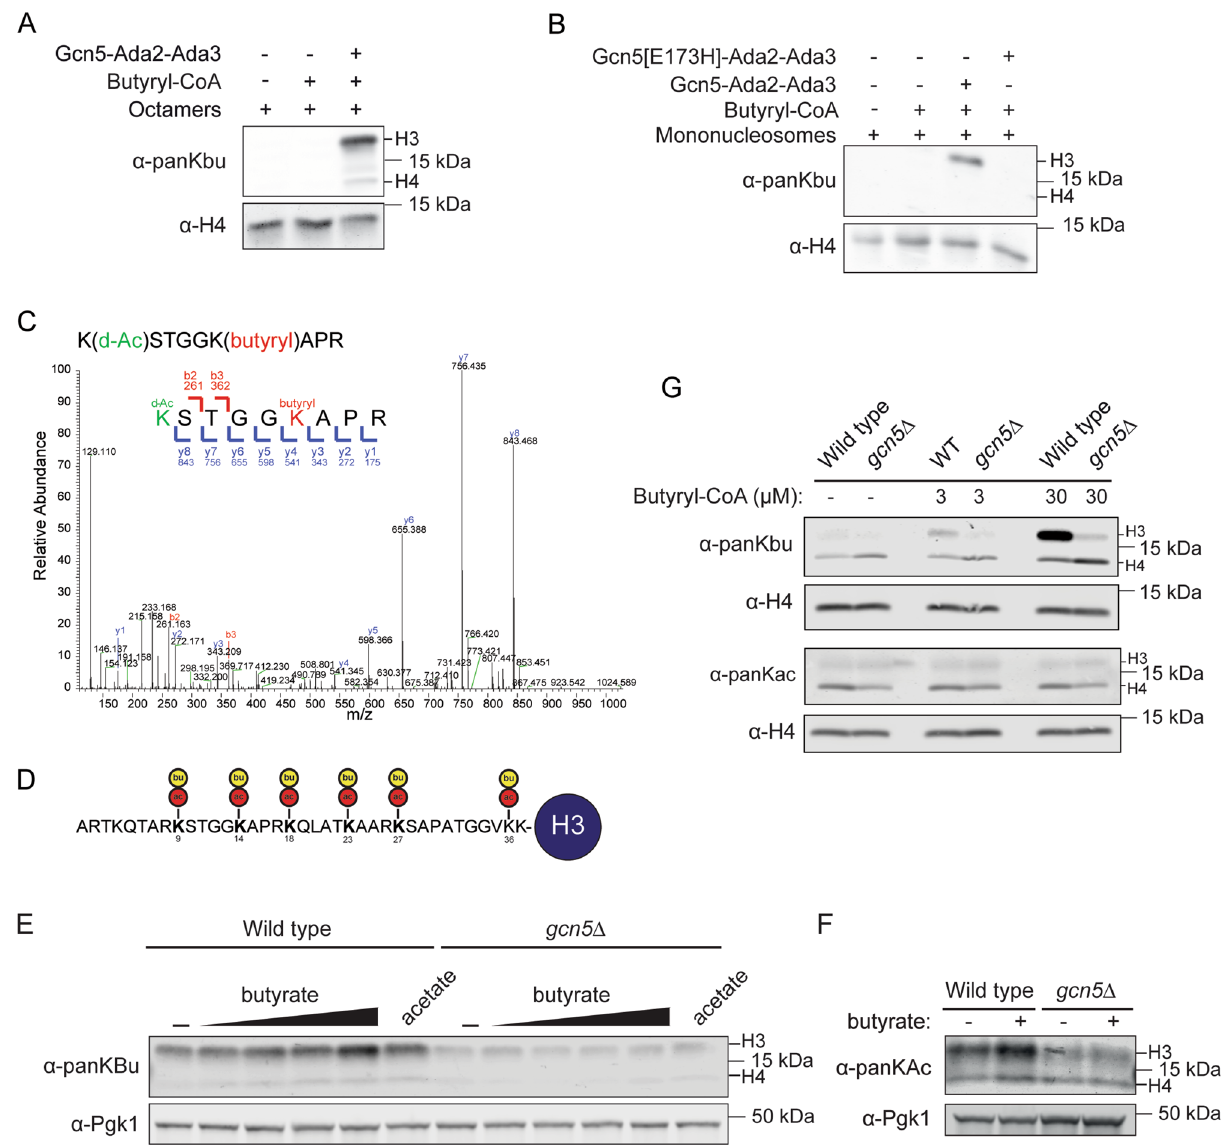
(green). ( D ) Schematic depicting residues 1–37 of H3 with acetylated (ac, red) and butyrylated (bu, yellow) lysine residues as identified by mass spectrometry. ( E , F ) Wild-type and gcn5Δ strains were treated with increasing concentrations of sodium butyrate (1, 2, 5, and 10 mM; pH 7.5) or sodium acetate (10 mM; pH 7.5) ( E ) or sodium butyrate (10 mM; pH 7.5) ( F ) for 3.5 h in the presence of 0.8 m sorbitol. Whole-cell extracts